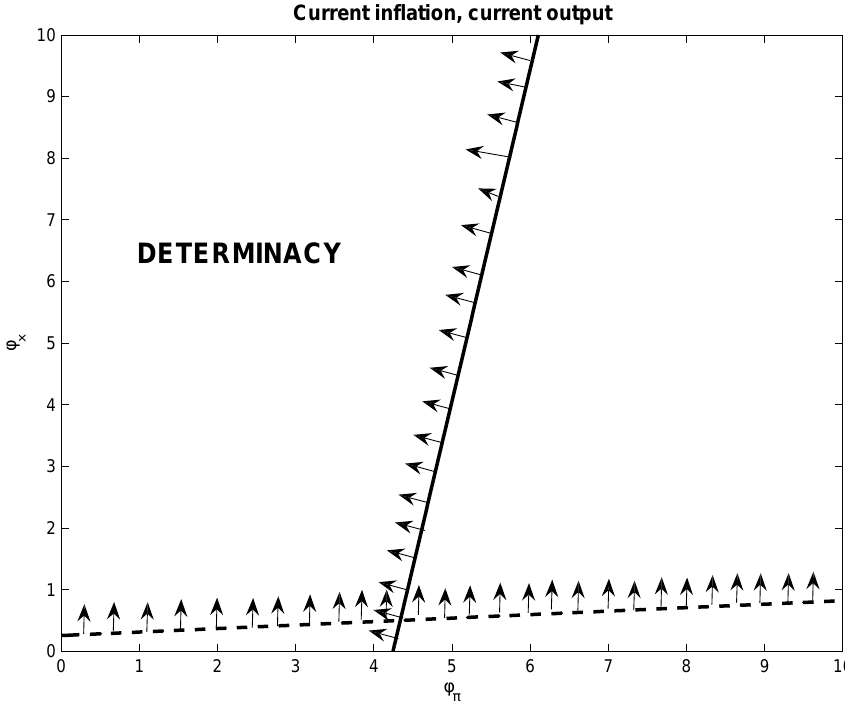
Figure 2. Determinacy regions for a Taylor rule with current inflation and current